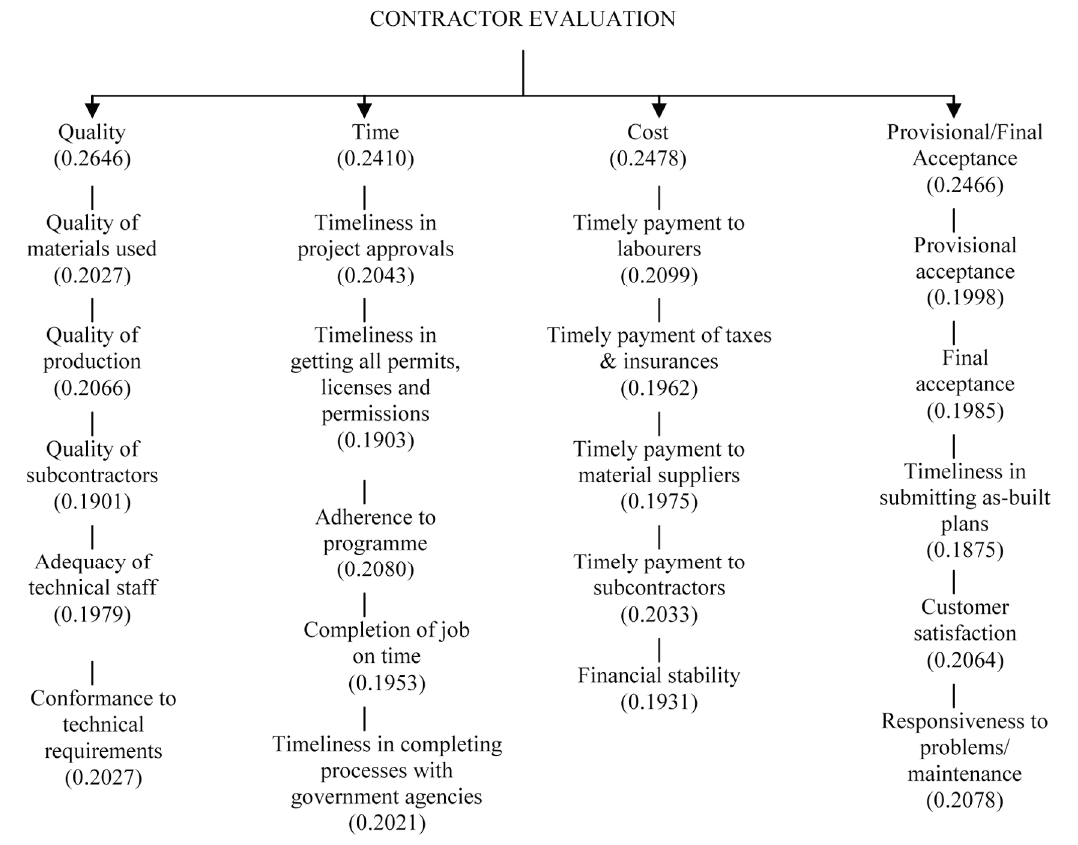
Fig. 3. Weights of main and